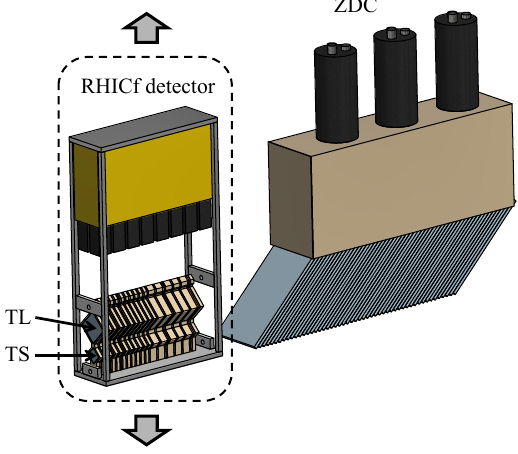
Figure 1: Schematic drawing of the RHICf detector installed in front of the ZDC. We moved the detector vertically to cover p